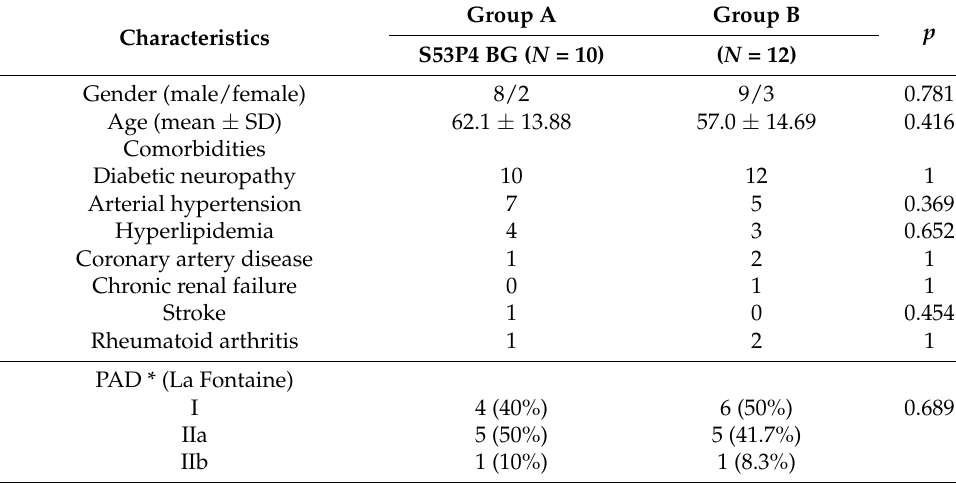
Table 1. Characteristics of study